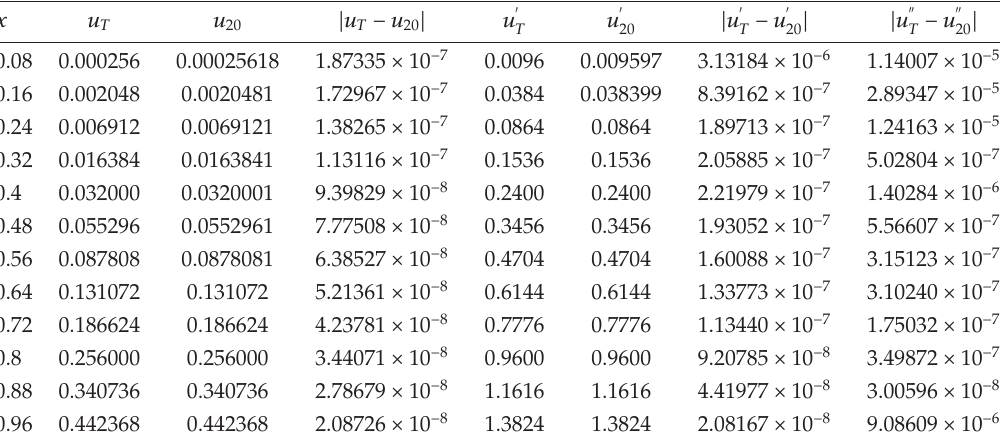
Table 7: The numerical results of Example